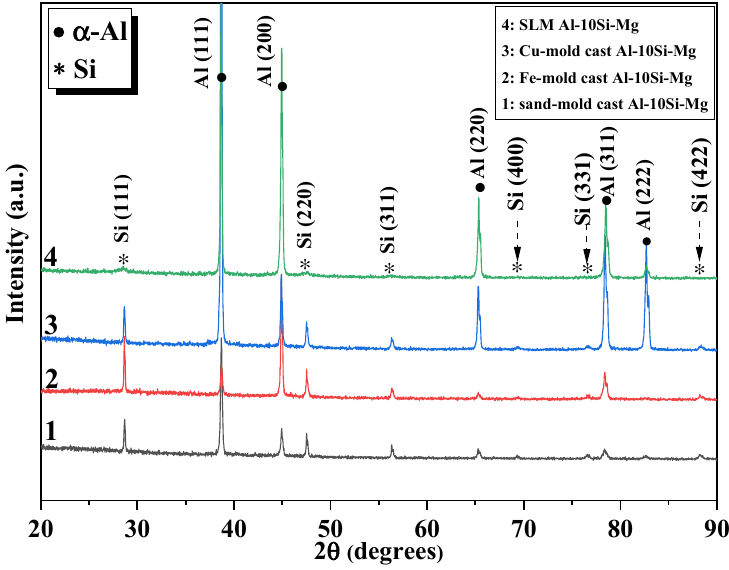
Figure 4. XRD patterns of Al-10Si-0.5Mg alloys fabricated under different